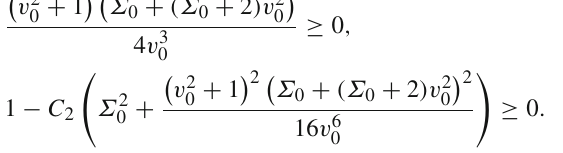
−√ γ − 1 , A = In Fig. 2 stability regions for SL − : v 0 = γ(γ(Σ + 2 ) − 2 ) 0 are depicted in the space of parameters, for (a) 4 (γ − 1 ) 3 / 2 C 2 = 0 . 5, (b) C 2 = 1 and (c) C 2 = 2 and γ ∈ [ 1 , 2 ] , −√ γ − 1 , Σ v, Σ in a where v 0 = 0 denote the values of fixed point at the sonic curve. The unshaded region repre- sents the region where A 0 < 0 or K 0 < 0, which is the non- physical region. The dotted red line corresponds to K = 0 and the thick blue line corresponds to A = 0. The region represented in gray color corresponds to the region where , δ v ) = ( 0 , 0 , 0 ) is a hyperbolic saddle. The region (δ Σ , δ A represented in black color corresponds to the region where , δ v ) = ( 0 , 0 , 0 ) is stable. Figure 2b reproduces the (δ Σ , δ A stability results shown in Figure 1 of [67] (with the excep- tion of a strip in the parameter space, represented in